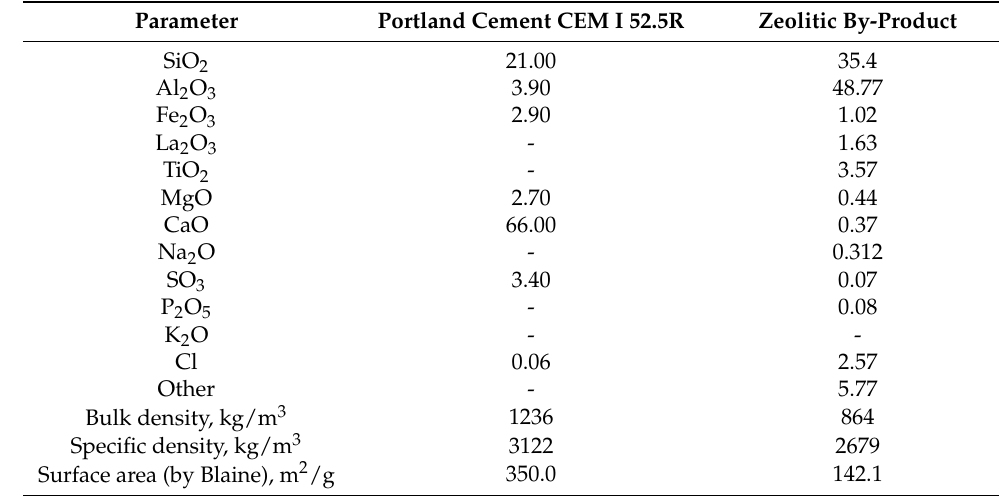
Table 1. Chemical composition of ordinary Portland cement and zeolitic by-product, % (by X-ray fluorescence (XRF) analysis.